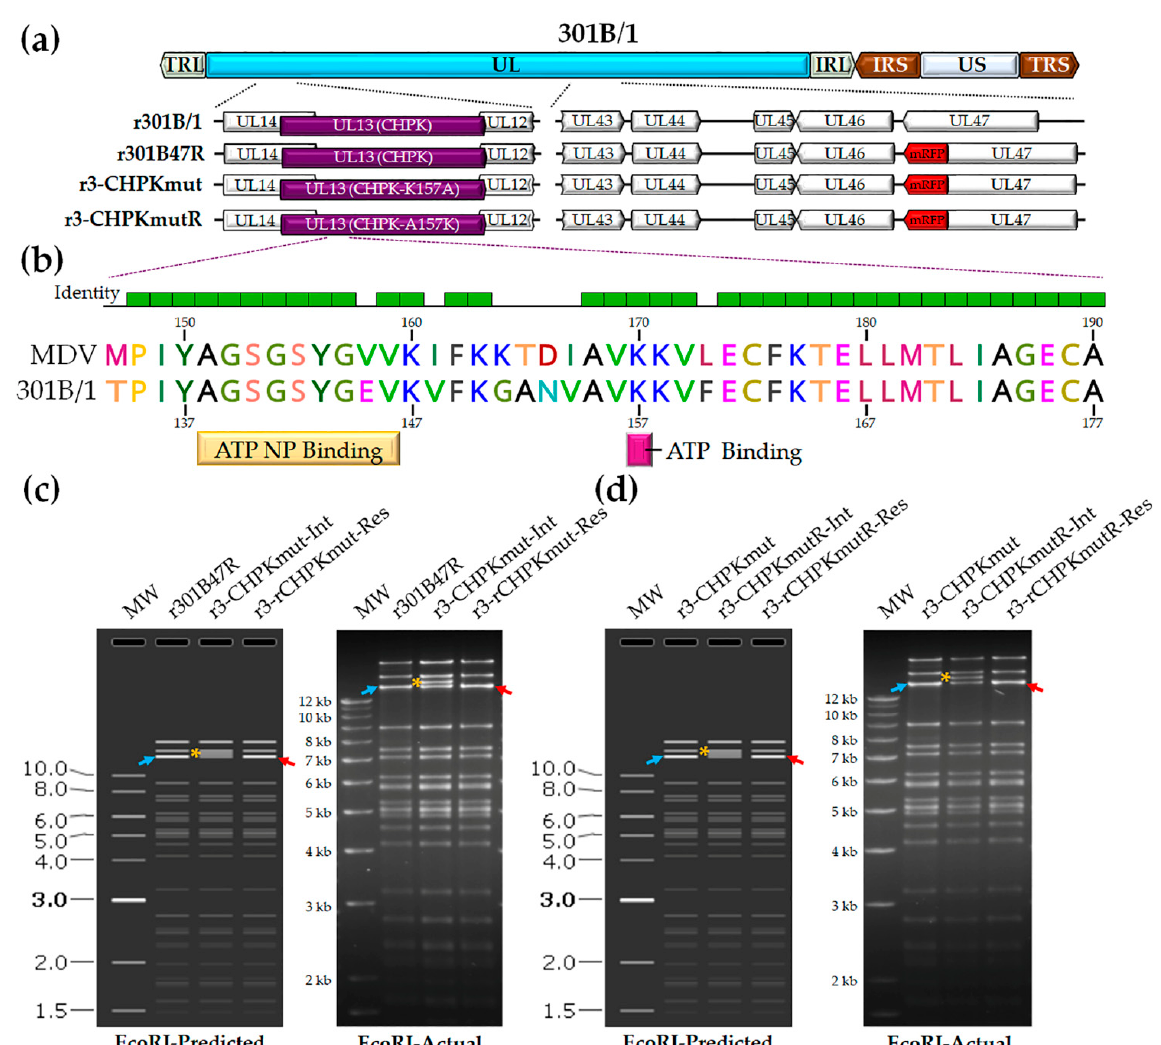
Figure 1. Generation of r301B/1clones. ( a ) Schematic representation of the 301B/1 infectious clone genome depicting the locations of the terminal repeat long (TRL) and short (TRS), internal repeat long (IRL) and short (IRS), and unique long (UL) and short (US) regions. The region of the UL spanning UL14 to UL12 and UL43 to UL47 are expanded to show the relevant genes within this region and modifications for each r301B/1 clone. ( b ) Alignment of MDV (RB-1B strain) and 301B/1 CHPKs at the ATP nucleotide binding (NP) and ATP binding sites using MUSCLE Alignment in Geneious Prime 2021.0.3 (Biomatters, Inc., San Diego, CA, USA). Lysine (K) at position 170 of MDV CHPK is required for the horizontal transmission of MDV [44] and the corresponding K157 of 301B/1 was targeted in this report. ( c ) The predicted (SnapGene software (from Insightful Science; available at snapgene.com) and actual RFLP analysis for generation of r3-CHPKmut (CHPK-K157A) of r301B/1 clones. BAC DNA obtained for r301B47R, the r3-CHPKmut-integrate (r3-CHPKmut-Int), and resolved clone (r3-CHPKmut-Res) were digested with EcoRI and electrophoresed through a 1.0% agarose gel. Integration of the AphAI sequence with the K157A mutation resulted in an increase in the 14,356 bp fragment ( → ) to 15,384 bp (*). Resolution of the AphAI sequence reduced the 15,384 bp fragment by 1028 bp to 14,356 bp ( ← ). ( d ) The predicted and actual RFLP analysis for the generation of the r3-CHPKmut rescuant virus (r3-CHPKmutR) in which the mutated A157 was changed back to a lysine (CHPK-A157K). BAC DNA obtained for r3-CHPKmut, r3-CHPKmutR-Int, and r3-CHPKmutR-Res were digested with EcoRI and electrophoresed through a 1.0% agarose gel. Fragments generated were exactly as described for generation of r3-CHPKmut ( c ). The 1 kb Plus DNA Ladder from Invitrogen, Inc. (Carlsbad, CA, USA) was used as a molecular weight marker. No extraneous alterations are